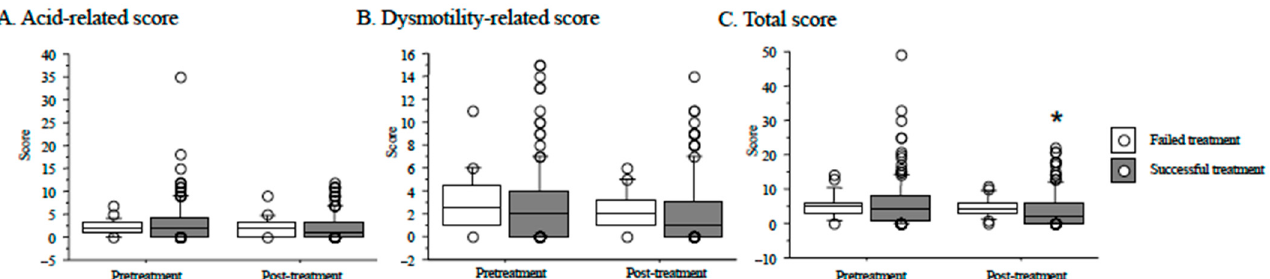
Figure 2. Correlation of the F-scale questionnaire score and time course from baseline to 2 months after treatment between patients with successful treatment and failed treatment in all 148 patients with successful H. pylori eradication. Scores in the F-scale questionnaire are acid-related ( A ), dysmotility-related ( B ), and total scores ( C ). *: p < 0.05 vs. score of patients with successful treatment.